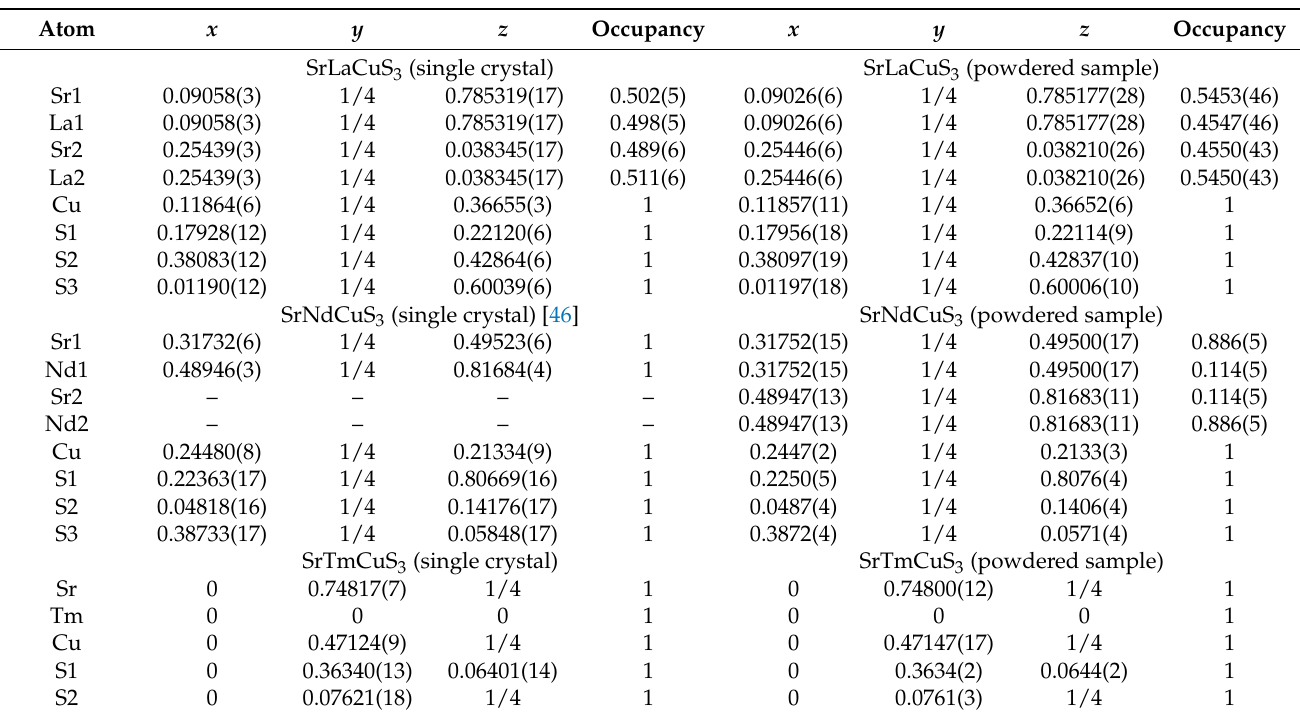
Table 3. Fractional atomic coordinates and occupancy of SrLnCuS 3 (Ln = La, Nd,